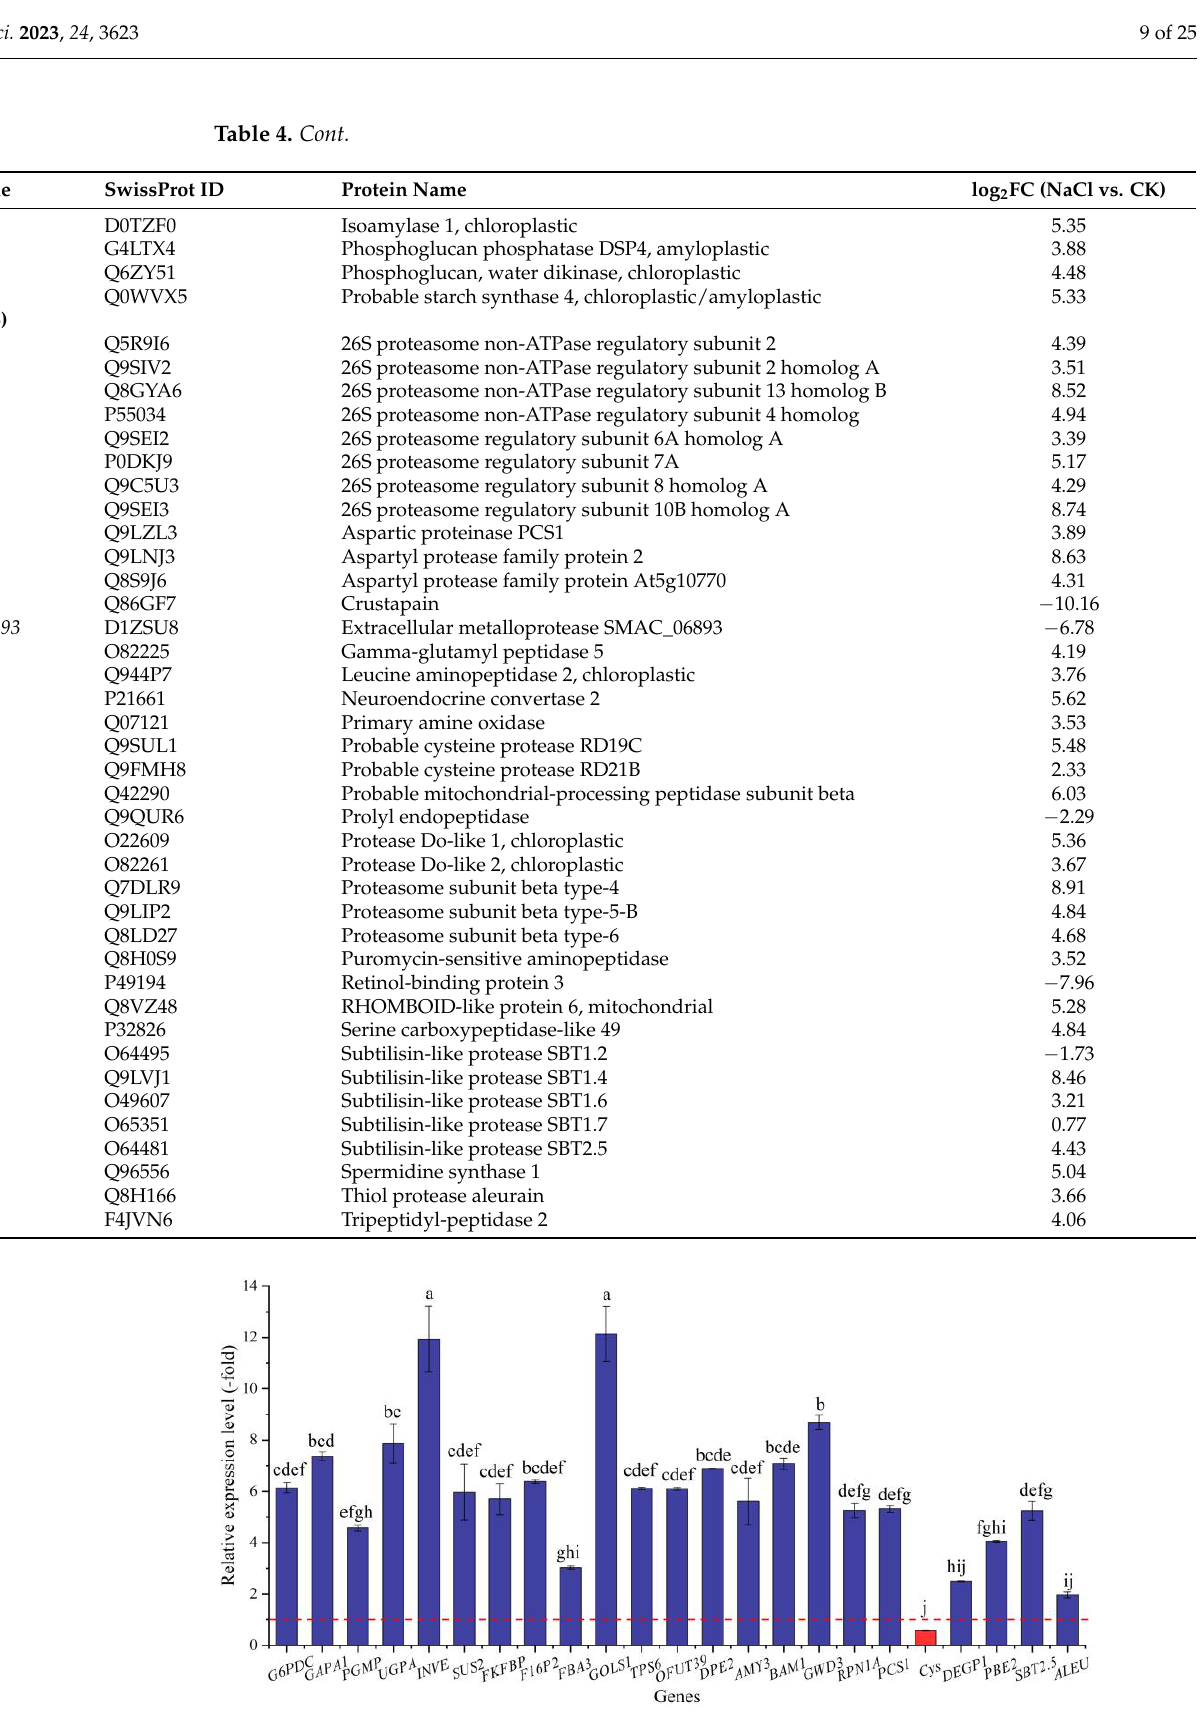
Figure 8. The RELs of genes directly associated with soluble sugar and protein metabolism in A. venetum seeds at 300 mmol/L NaCl vs. CK (mean ± SD, n = 3). Different letters represent a significant difference ( p < 0.05) among different genes. The red dotted line differentiates UR (>1) and DR (<1).